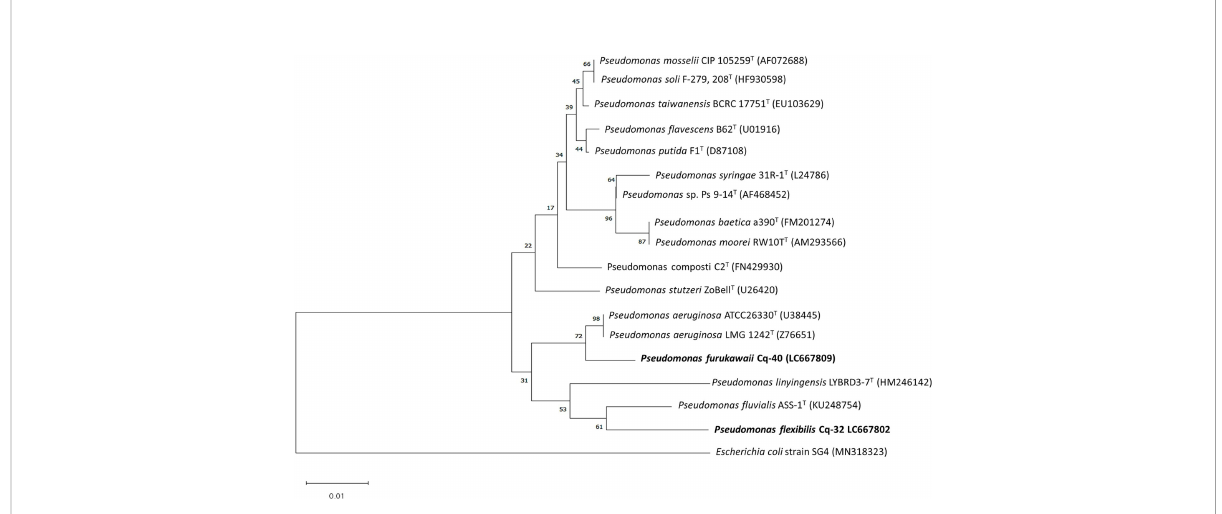
FIGURE 2 Phylogenetic tree of the strains Cq-32 and Cq-40 and related type strains within family Pseudomonadaceae based on partial 16S rRNA gene sequences. The neighbor-joining algorithm constructed the tree in